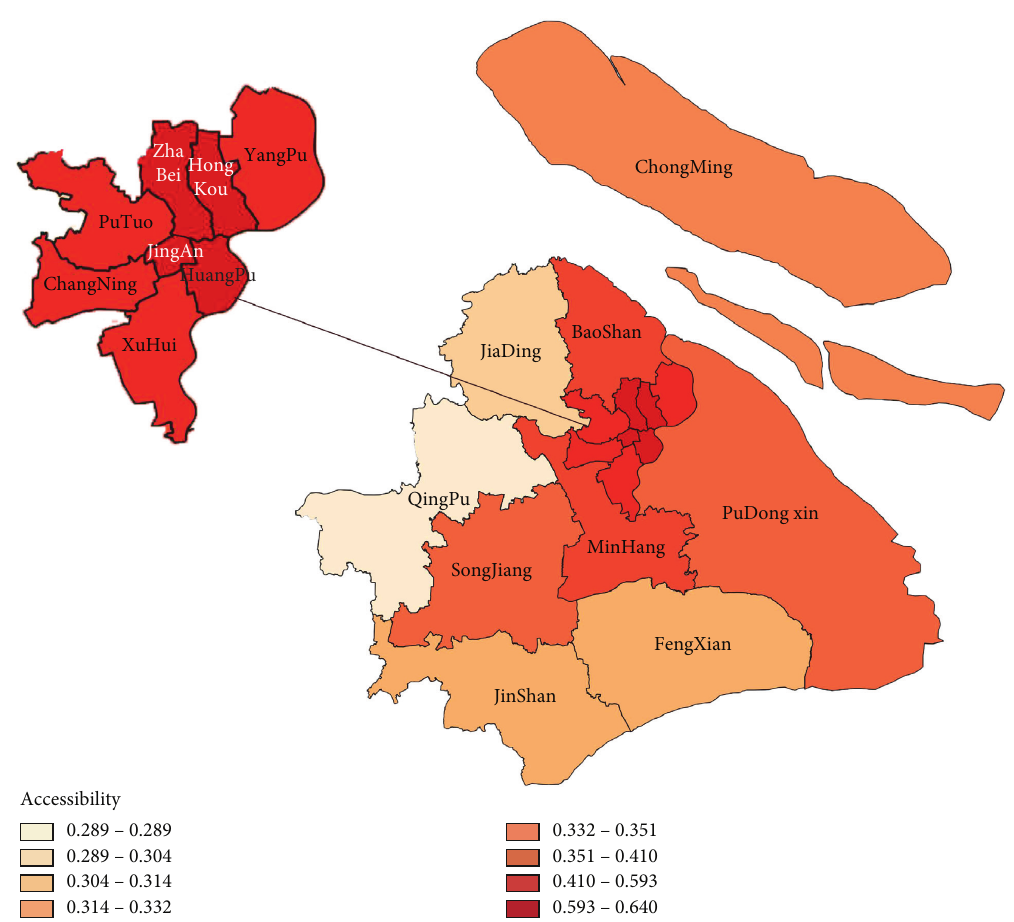
Figure 6: Accessibility map of dockless sharing bikes in each administrative region of